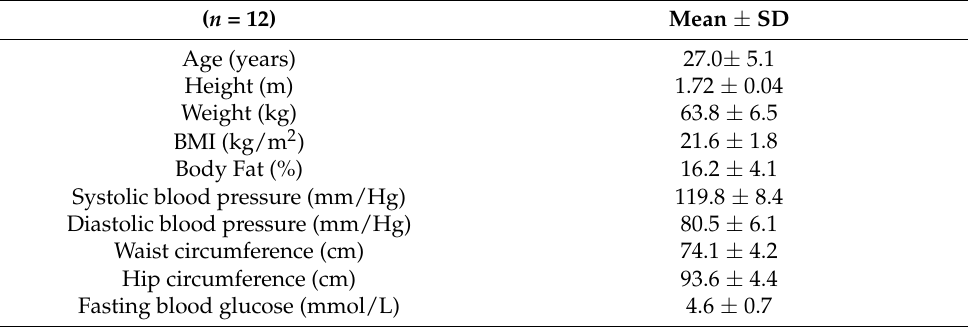
Table 3. Anthropometric and physiological parameters of